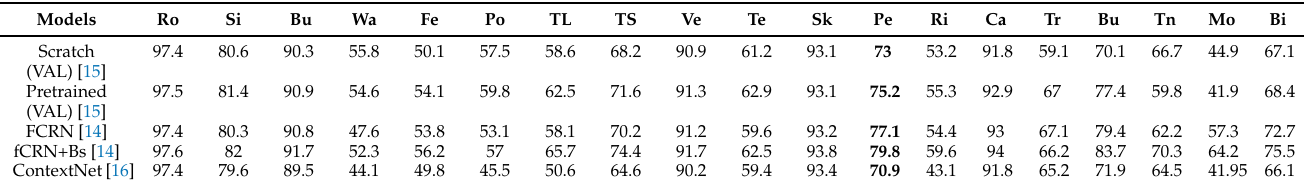
Table 2. Per-class IoU (%) results for different models on the Cityscapes Validation set. Classes: Road, Sidewalk, Building, Wall, Fence, Pole, Traffic Light, Traffic Sign, Vegetation, Terrain, Sky, Person, Rider, Car, Truck, Bus, Train, Motorcycle and Bicycle, respectively. The column of Person Class is highlighted.